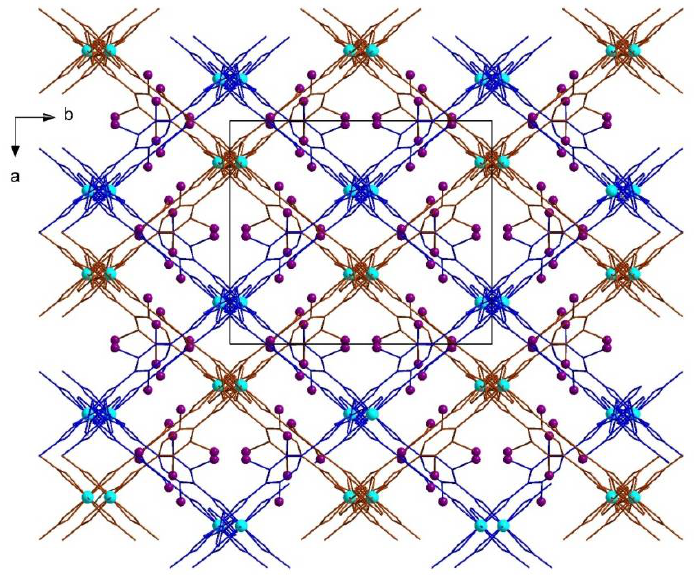
Figure 4. A fragment of the structures of the compounds on the example of 2 showing interpenetrated frameworks colored with blue and brown.